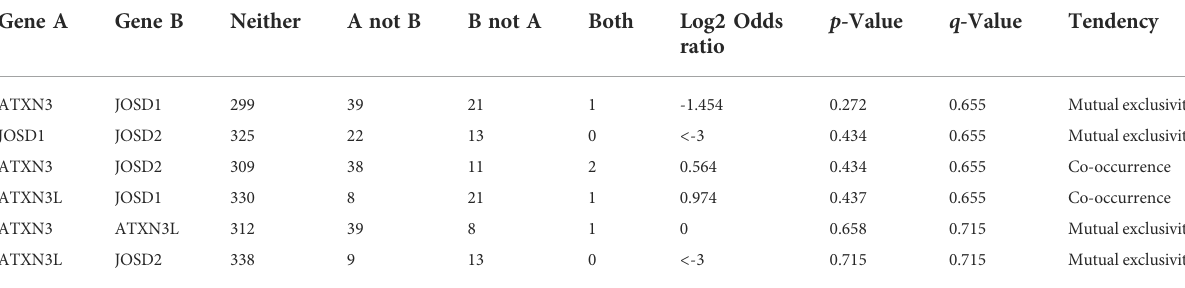
TABLE 4 Mutual exclusivity of MJDs family